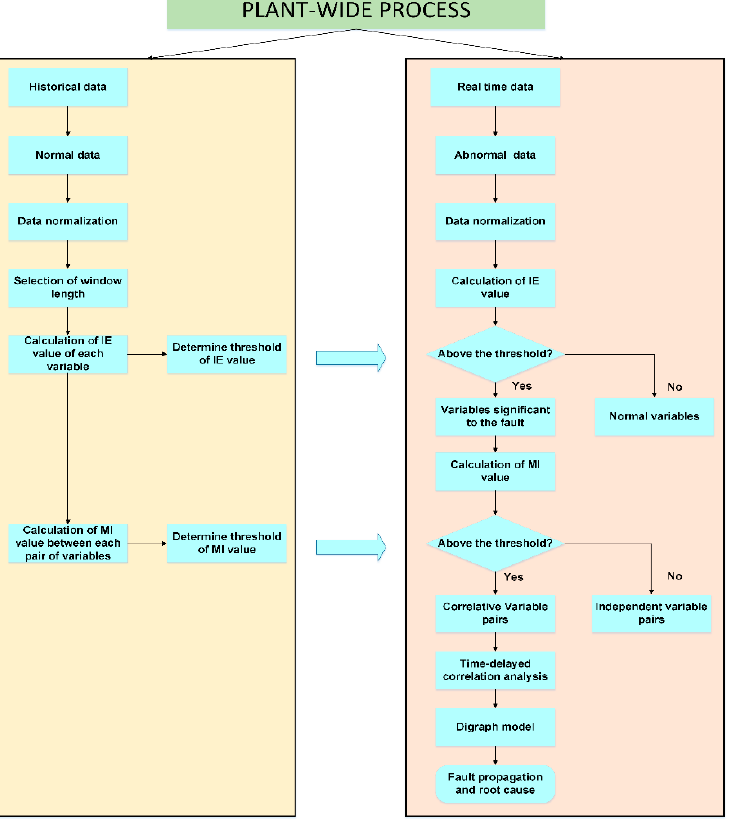
Figure 3. The framework of the proposed fault diagnosis